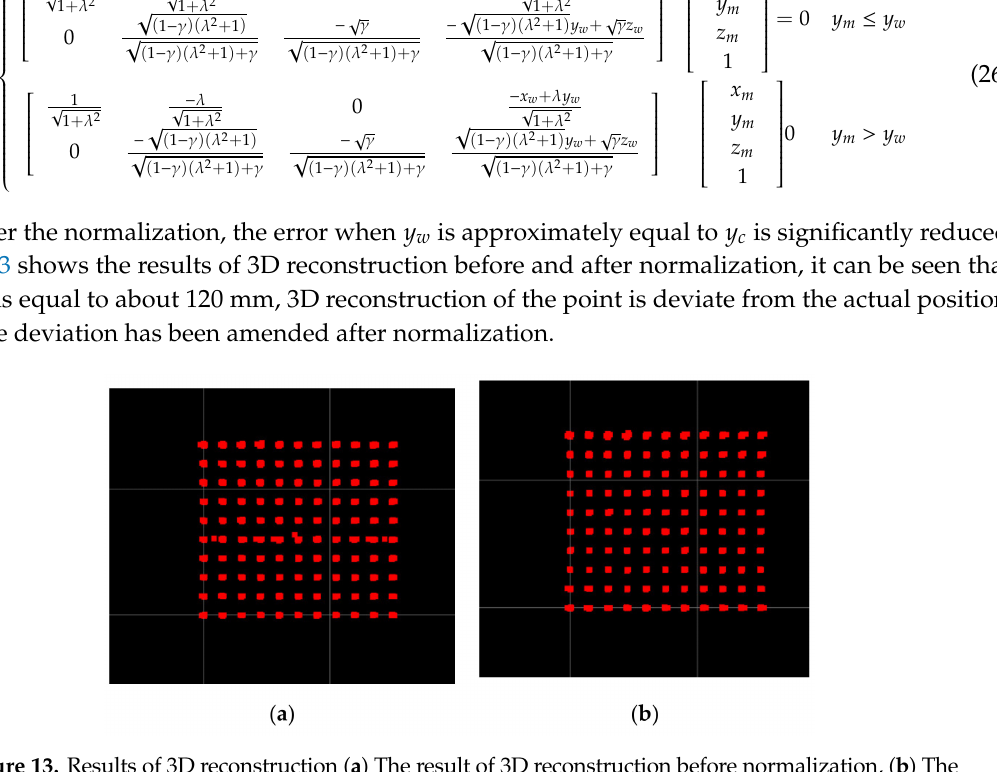
Figure 13. Results of 3D reconstruction ( a ) The result of 3D reconstruction before normalization, ( b ) The result of 3D reconstruction after normalization.